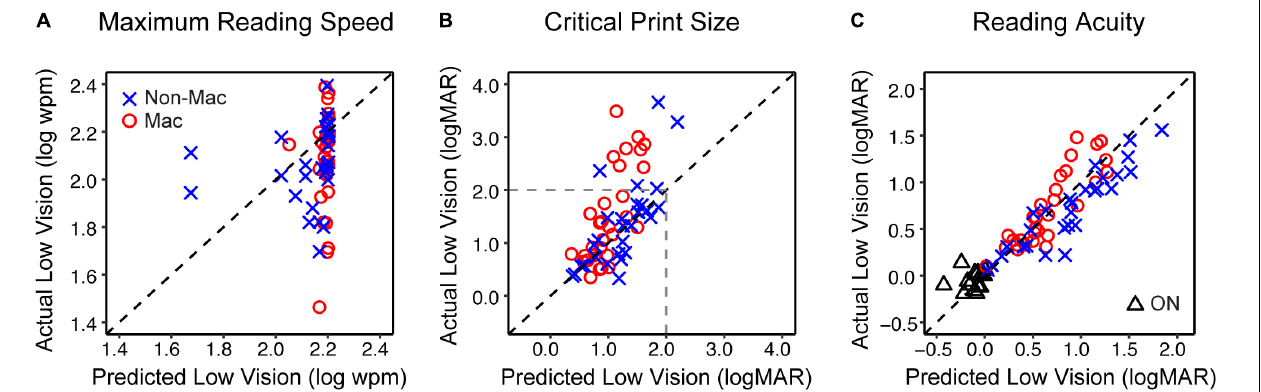
FIGURE 5 | The validity of simulating the reading performance of low vision individuals. (A) The comparison of the maximum reading speed between actual low vision and predicted low vision from the simulation. The blue crosses and red circles represent the Non-Mac and Mac groups, respectively. (B) Comparison of the critical print size for actual and predicted low vision from the simulation. Note that critical print sizes larger than 2.0 logMAR (dashed lines) may be unreliable due to limitations on the tested print size range. (C) Comparison of reading acuity for actual and simulated low vision from the simulation. Comparisons between actual and simulated reading acuity of the Older Normal (ON) group are also shown (black triangles). Note that for the ON group this comparison was only conducted on reading acuity.